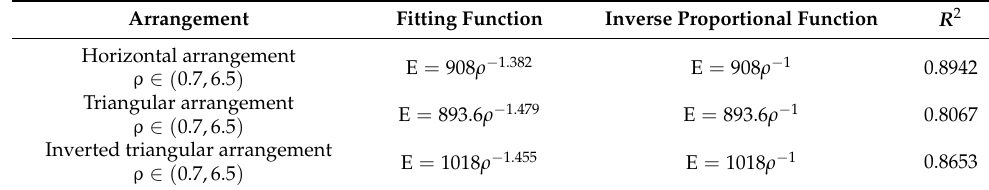
Table 3. Comparison results between the fitted function and the inverse proportional function.